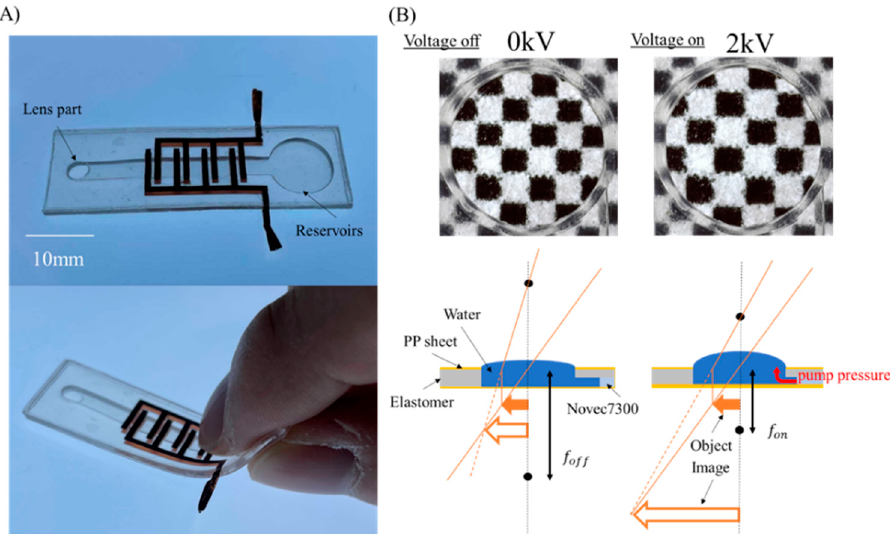
Figure 2. ( A ) Focus-tunable lens powered by an EHD pump. ( B ) Schematic diagram of focus-tunable lens driven by EHD pump.